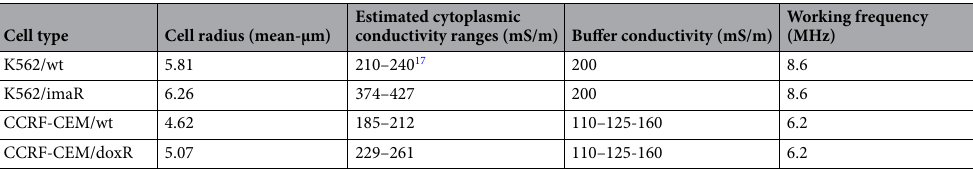
Table 2. Radii 25 and estimated cytoplasmic conductivity ranges of K562/wt, K562/imaR, CCRF-CEM/wt, and CCRF-CEM/doxR cells used in the determination of working frequency of the DEP-D unit in